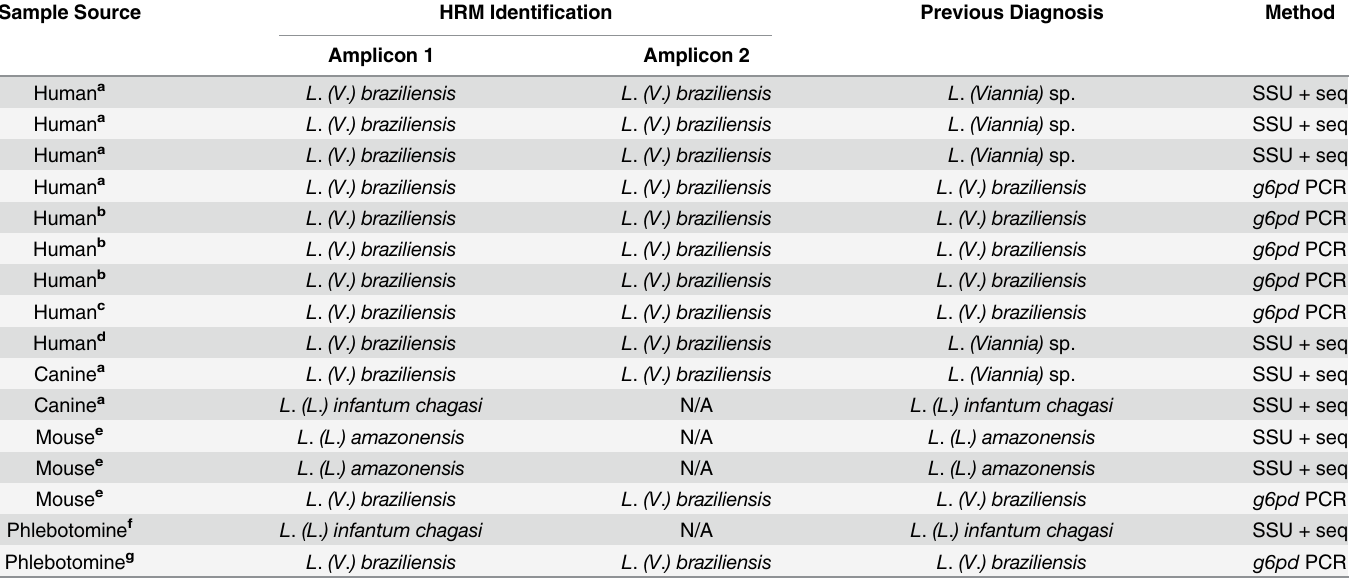
Table 4. Identification of Leishmania in clinical and experimentally infected and field samples by the HRM analysis targeting hsp70 gene. The hsp70 amplicons 1 or 2 of DNA from each sample were submitted to the HRM analysis. The results were compared with a previous identification performed by SSU rDNA sequencing [17] or g6pd PCR [18]. (a) fresh tissue from hamster inoculated with infected sample; (b) cell culture of the human isolated strain; (c) human fresh tissue; (d) human paraffin-embedded tissue; (e) experimentally infected BALB/c mice; (f) naturally infected Lutzomyia (Lutzomyia) longipalpis ; and (g) naturally infected Lu . (Nyssomyia) whitmani ; (N/A): not